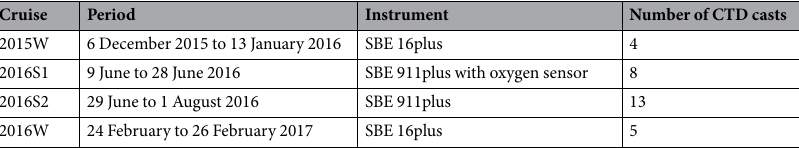
Table 1. The time and instruments of the four